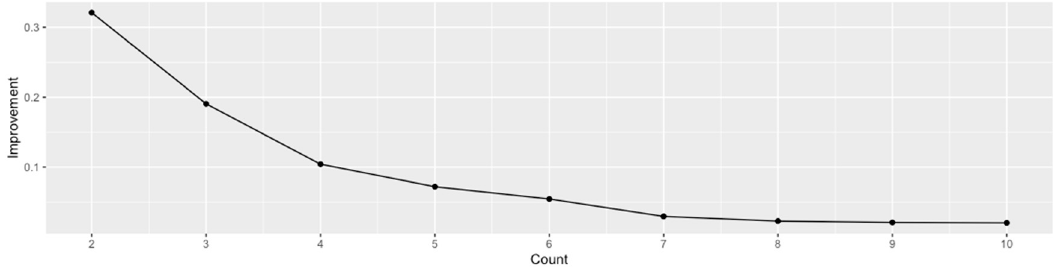
Figure 2. Increments in between-cluster variance.